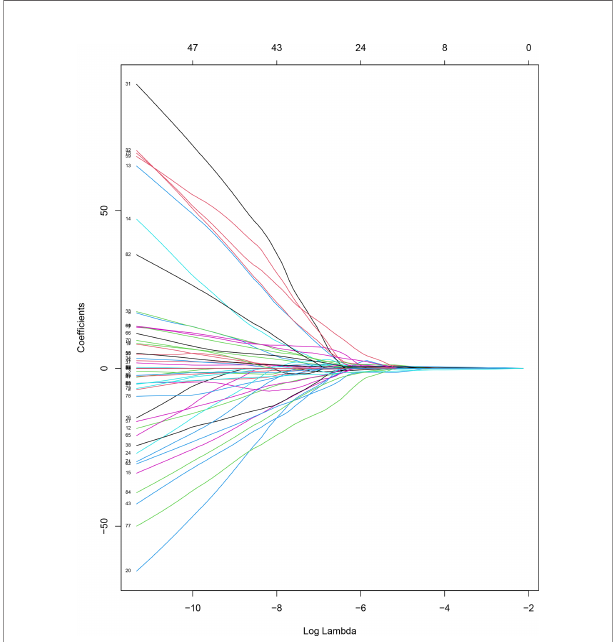
FIGURE 5 | Coef fi cient convergence graph of CEUS radiomics features.